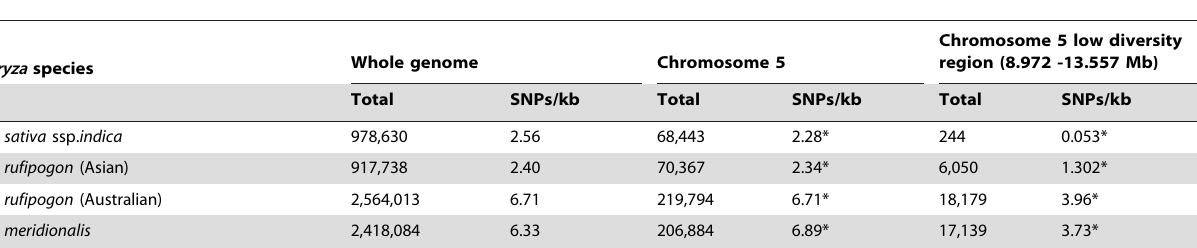
Table 1. Single nucleotide polymorphisms in cultivated and wild Oryza as compared with O. sativa ssp. japonica cv. Nipponbare.